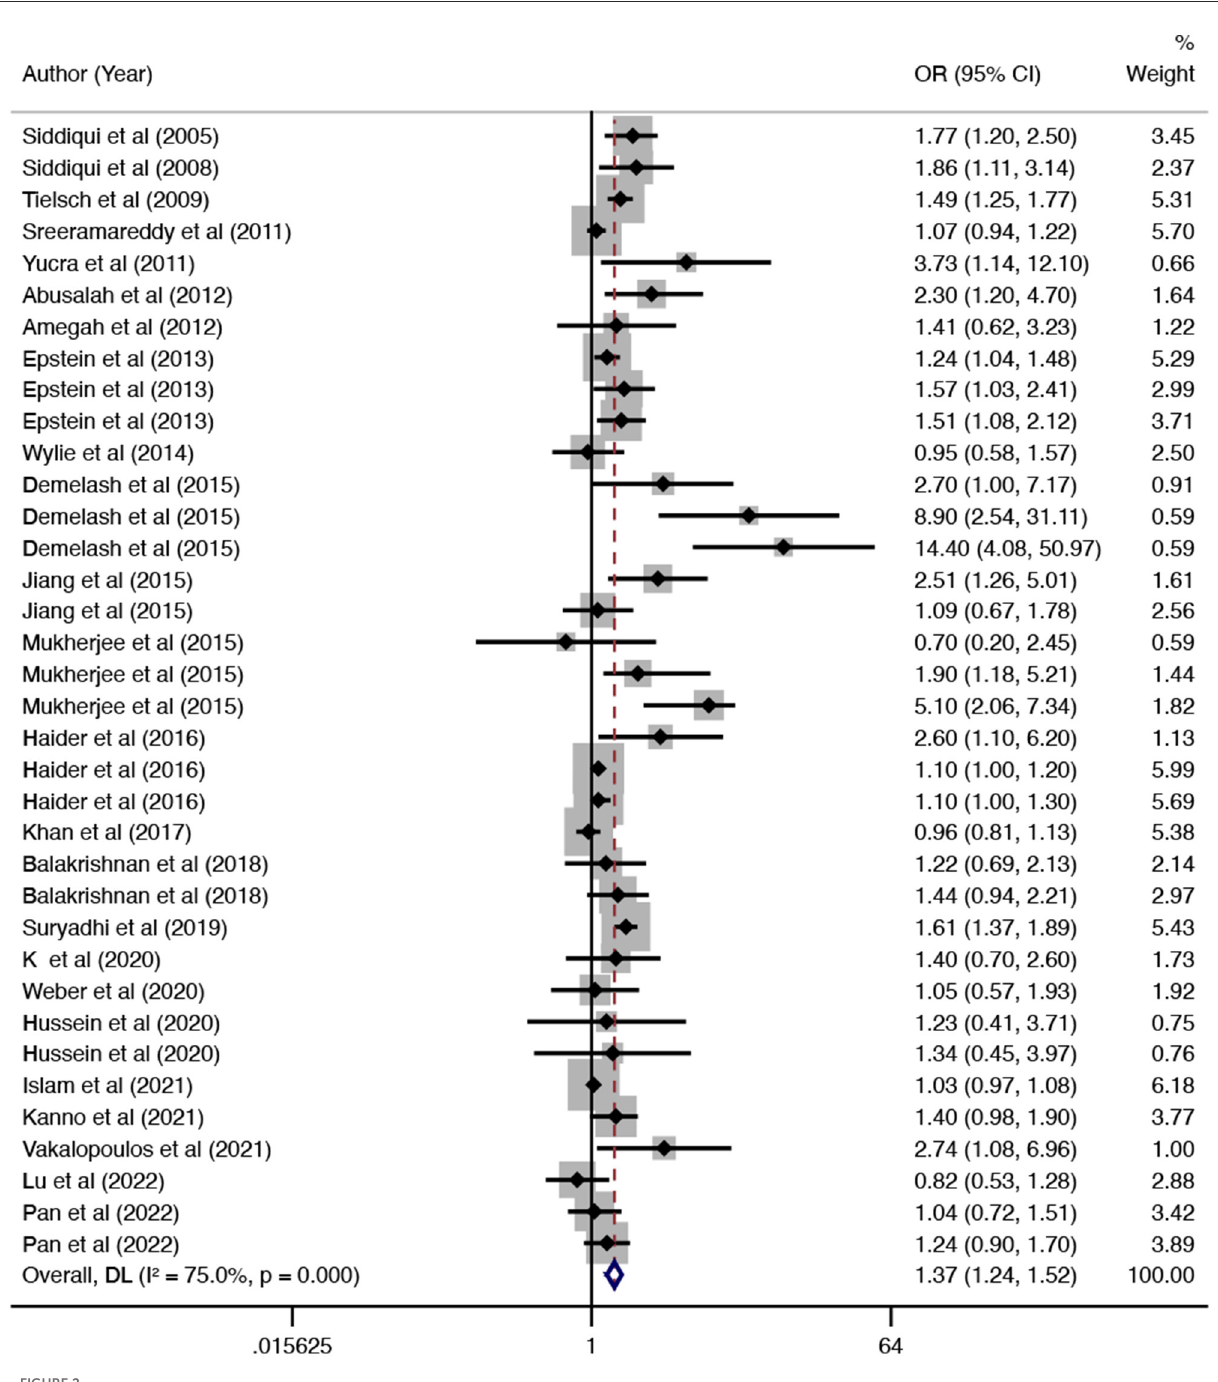
Subgroup and meta-regression analyses To explore possible sources of heterogeneity across eligible studies, we performed subgroup analyses for LBW and SGA (Table 2). Notably, the association between polluting cooking fuels and the risk of LBW was consistent in all subgroups examined, except for the subgroup conducted according to fuel types. In the